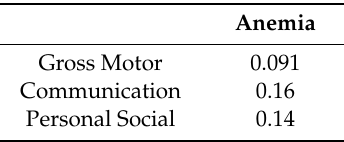
Table 4. Proportion of the total association of malaria on risk of gross motor, communication, and personal social delay that is mediated by anemia ( n =